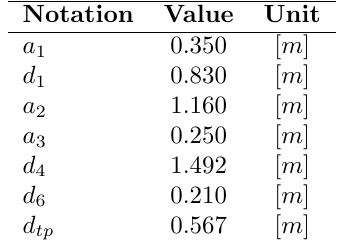
Table 7: Comau SMART 5 - Geometric Dimensions (Notation According to Figure 12). Table 9: Technical Information of the Beckhoff